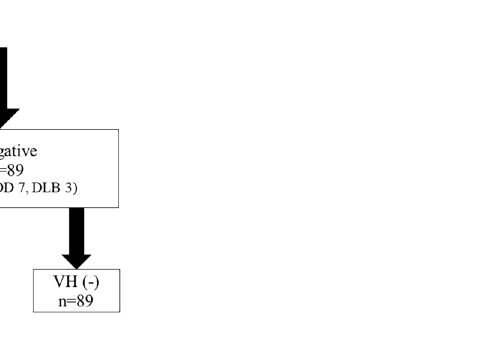
Figure 2. Flow chart of follow-up observation for 5 years (radiologist